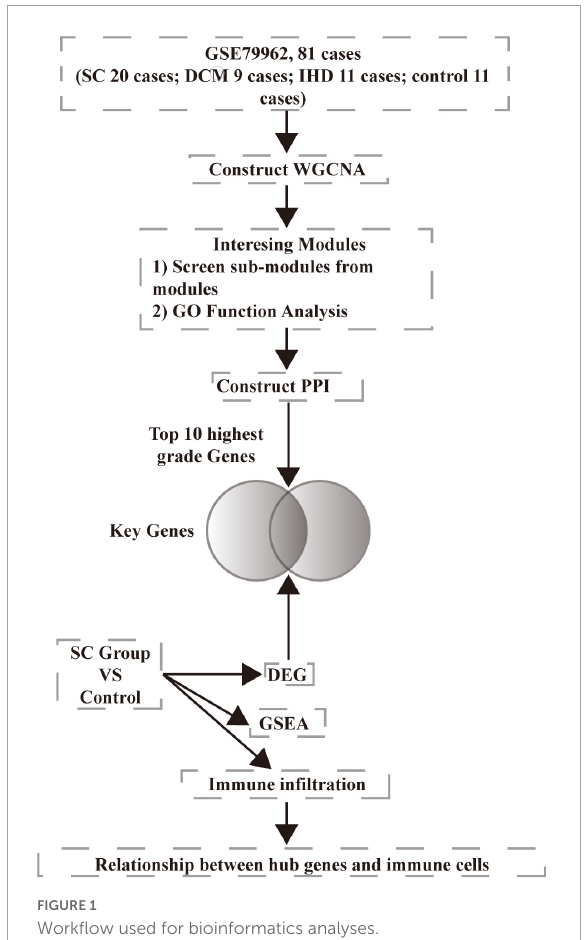
FIGURE1 Workflow used for bioinformatics